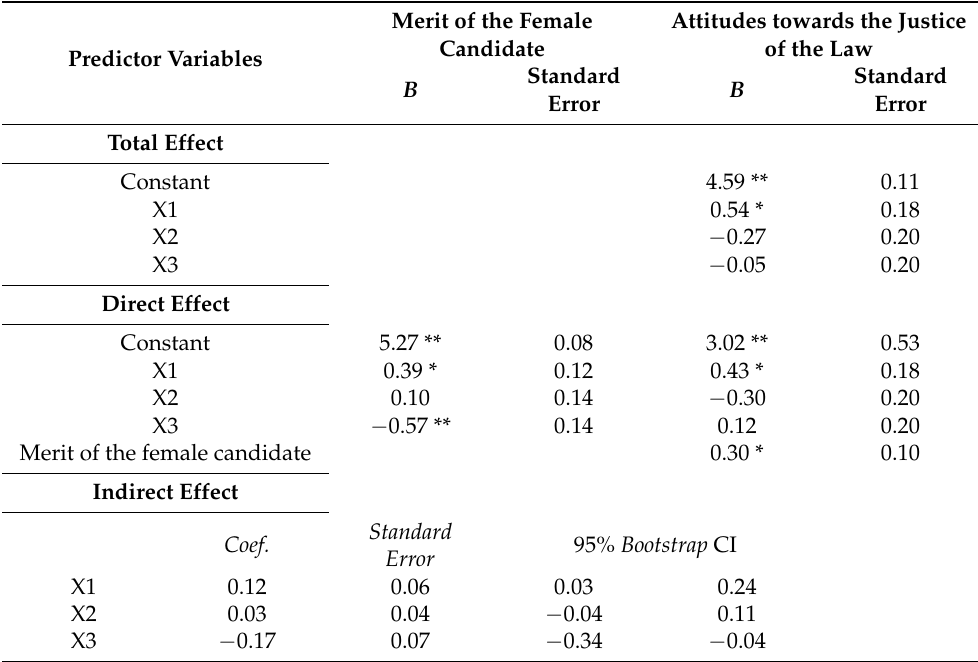
Table 5. Testing the Mediating Effect of the Female Candidate’s Merit on the Relationship between AAM Type and Attitudes towards the Justice of the Law. Merit of the Female Attitudes towards the Candidate Predictor Variables